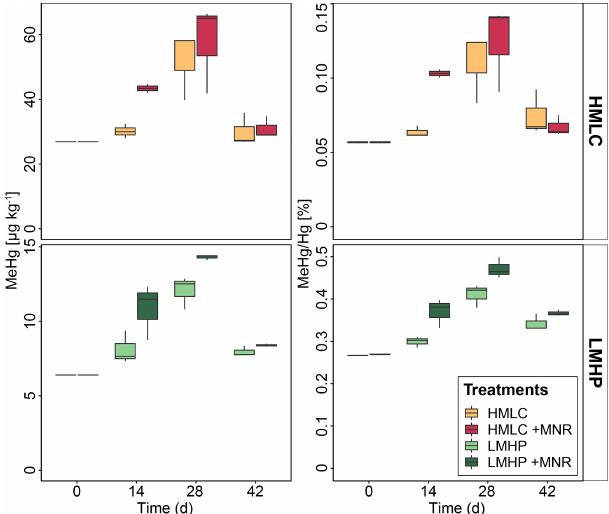
Figure 10. Soil MeHg concentrations and MeHg / Hg ratios over the course of the experiment for cornfield soils (HMLC, yellow/red) and pasture field soils (LMHC, lime/green). The highest net methy- lation was observed during first flooding for + MNR treatments and during the draining period for microcosms without manure addi- tion. A significant decrease in MeHg / Hg was observed during the second flooding for all